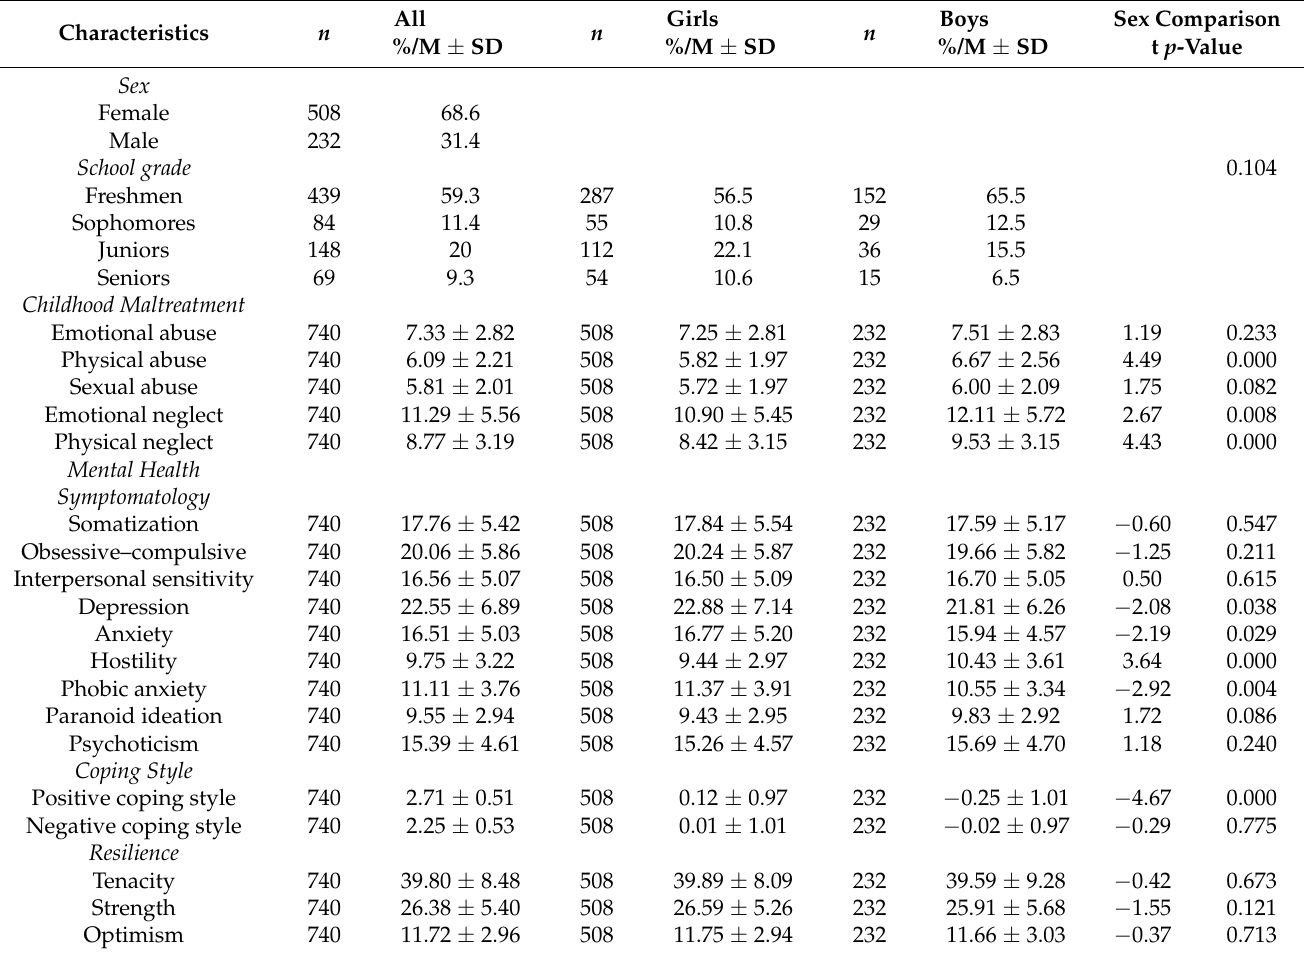
Table 1. College student’s demographic characteristics for the entire sample and divided by sex ( n =